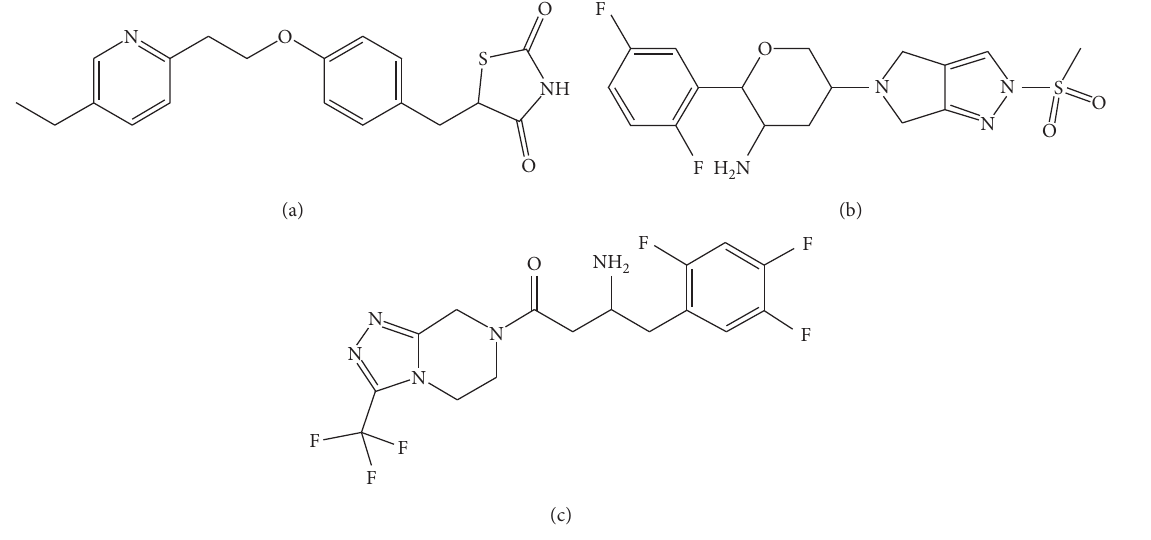
Figure 1: Structures of pioglitazone (a), omarigliptin (b), and sitagliptin (c). Table 1: Gradient elution procedure of the method.